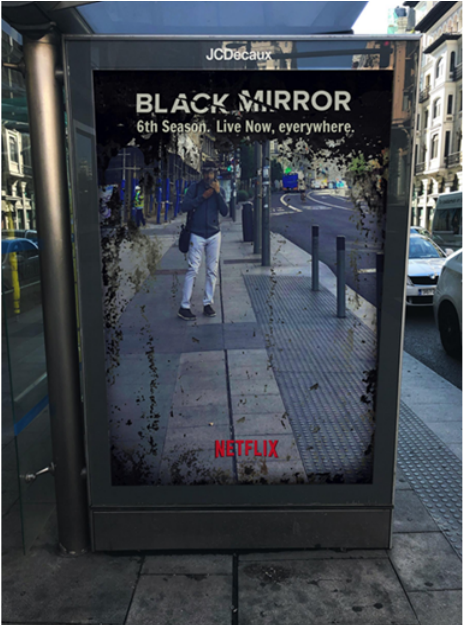
Figure 1 . Brother Ad School Spain created the outdoor advertisement inspired by the Covid-19 pandemic for